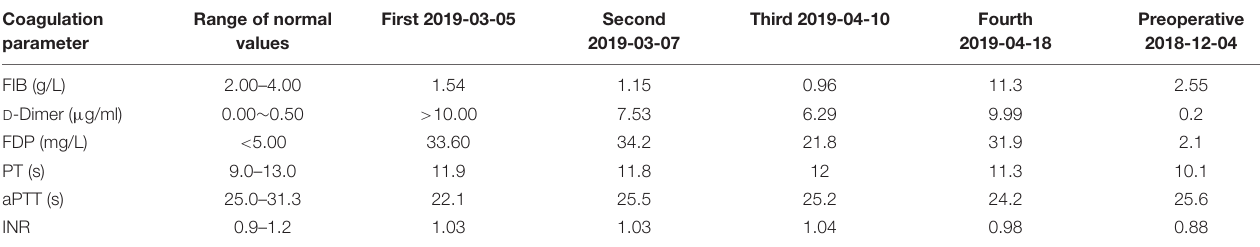
TABLE 1 | Coagulation parameters for the patient described in this study.